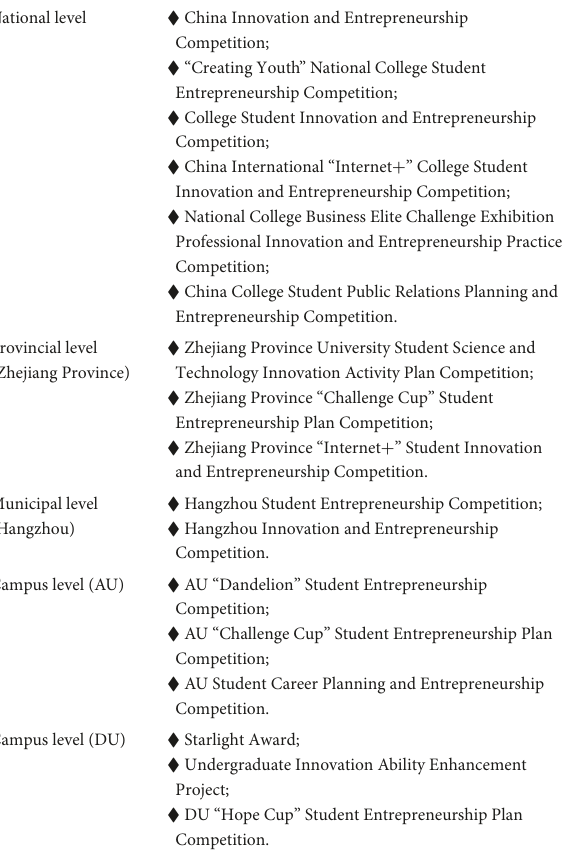
TABLE 2 Various types of innovation and entrepreneurship competition projects at all levels (selected). National